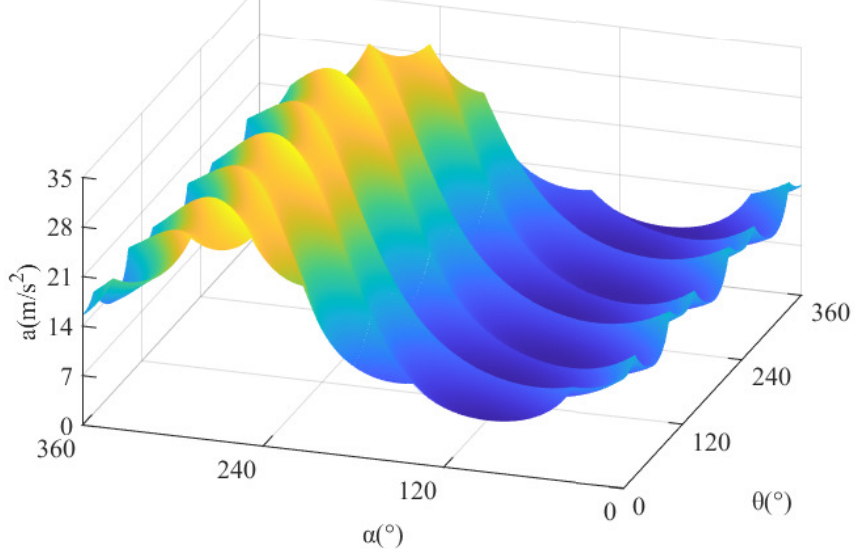
Figure 5. The relation among the acceleration, orientation, and the direction of the